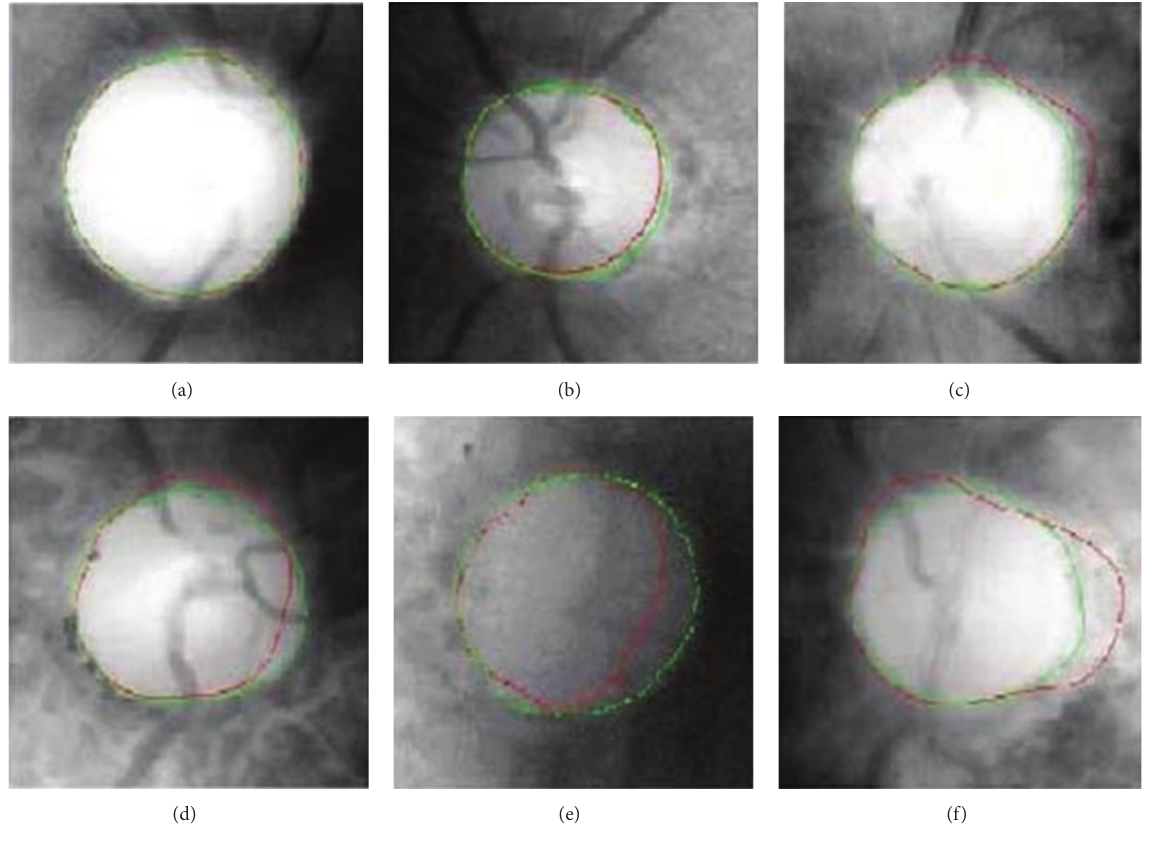
Figure 23: Representative